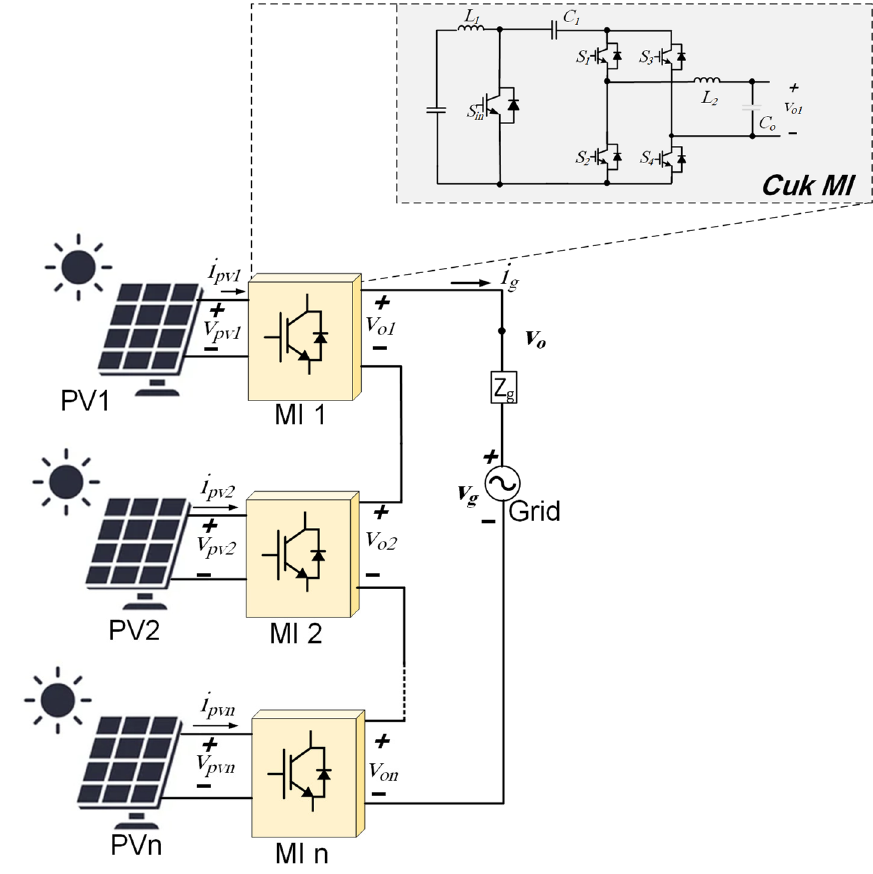
Figure 2. The proposed